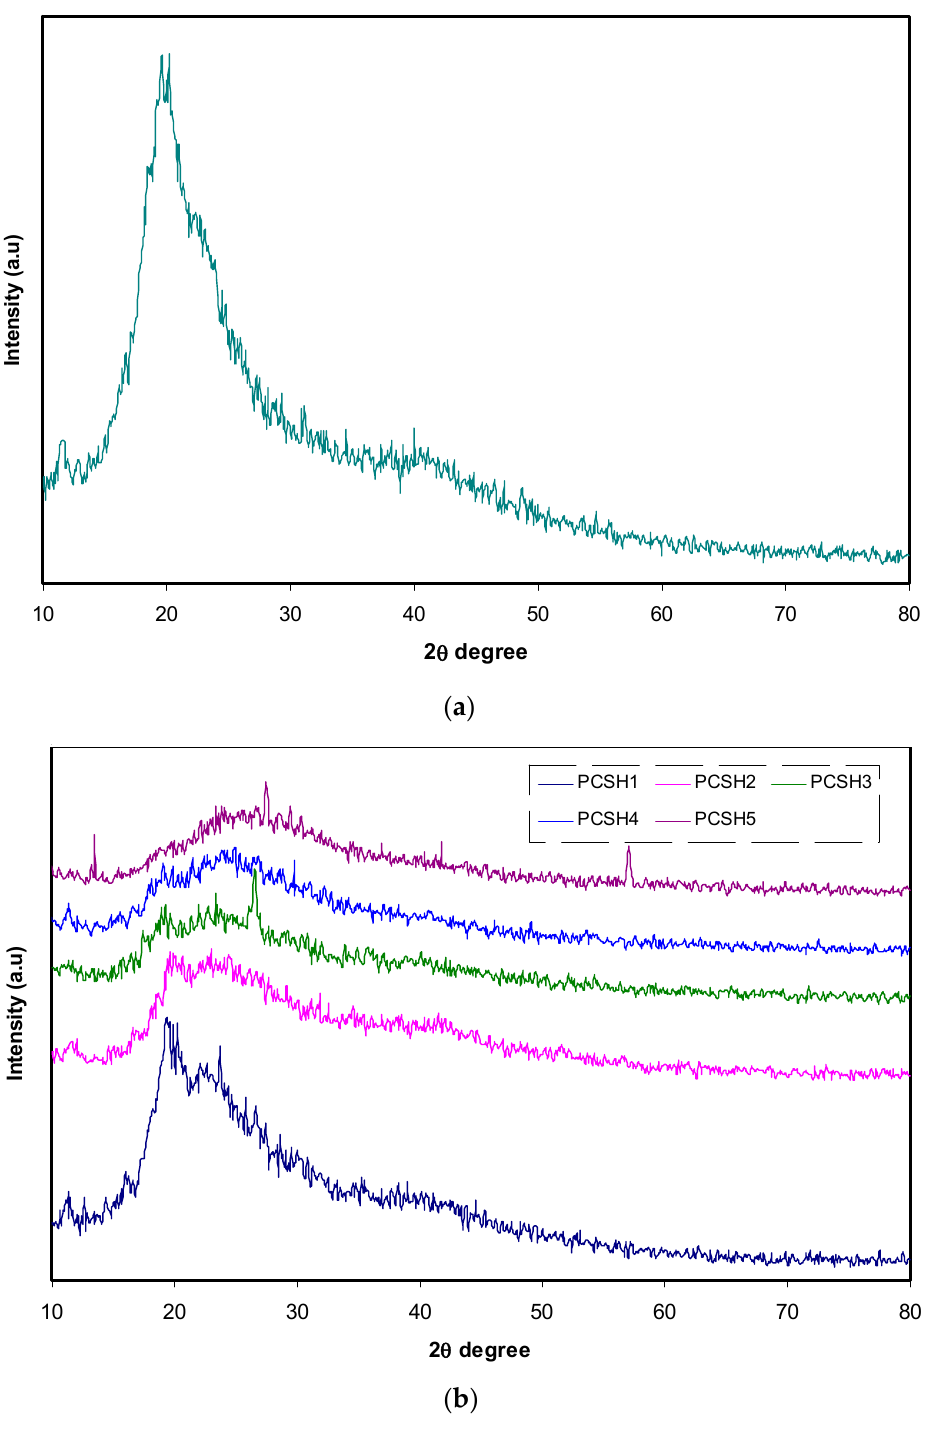
Figure 1. X-ray di ff raction (XRD) spectra for ( a ) pure PVA / CS polymer blend and ( b ) PVA / CS / NH 4 SCN Figure 1. X-ray diffraction (XRD) spectra for ( a ) pure PVA/CS polymer blend and ( b ) electrolyte systems at room PVA/CS/NH 4 SCN electrolyte systems at room temperature.